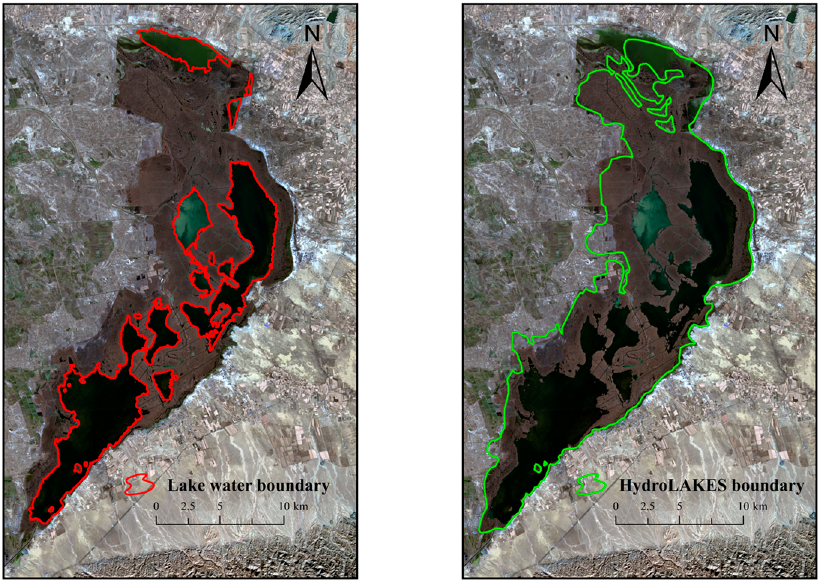
Figure 4. Comparison of the lake water boundary between the HydroLAKES dataset and the result of the NDWI formula in Wuliangsu Lake (the Landsat-8 image on 7 November 2013 was the selected example).